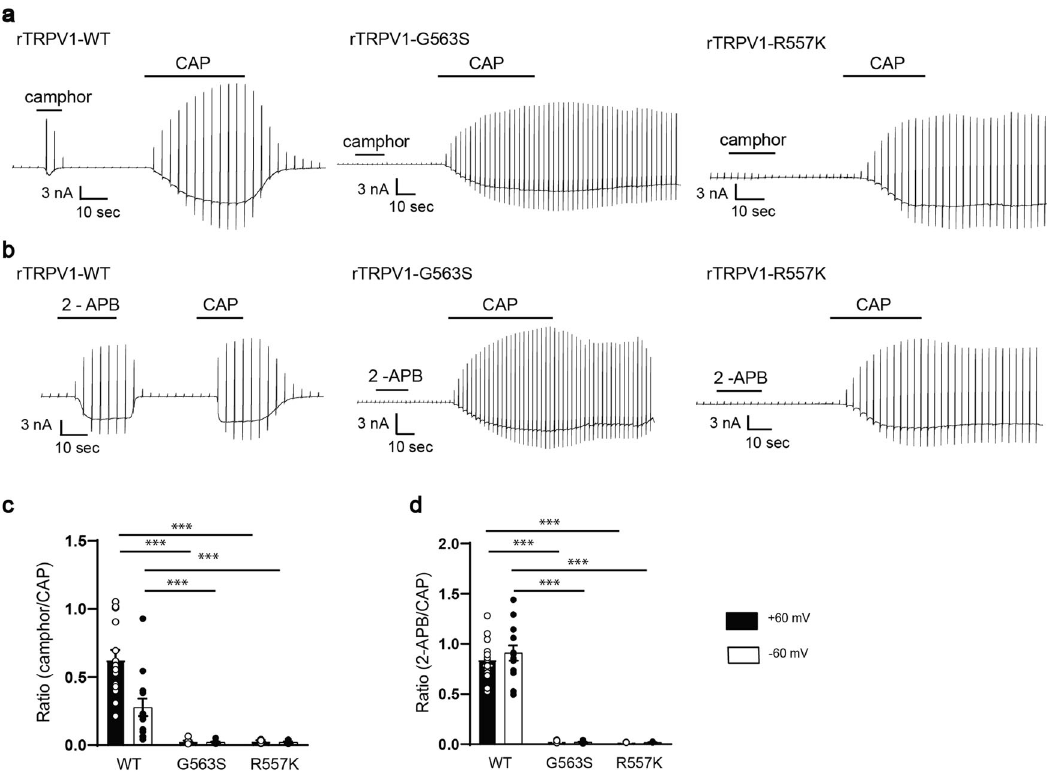
Fig. 4 Effect of rat TRPV1 mutations G563S and R557K on agonistic action of camphor and 2-APB. a Representative current traces for HEK293T cells expressing WT, rTRPV1-G563S, or rTRPV1-R557K stimulated with camphor (10 mM) followed by CAP (1 μ M). b Representative current traces for HEK293T cells expressing WT, rTRPV1-G563S, or rTRPV1-R557K stimulated with 2-APB (300 μ M) followed by CAP (1 μ M). c Comparison of the normalized current densities ( I camphor / I CAP ) for WT, rTRPV1-G563S, or rTRPV1-R557K expressed in HEK293T cells at ±60 mV ( I camphor / I CAP for WT: 0.63 ± 0.07 at + 60 mV and 0.28± 0.06 at − 60 mV, n = 14; G563S: 0.03 ± 0.01 at + 60 mV and 0.02 ± 0.01 at − 60 mV, n = 8; R557K: 0.03 ± 0.01 at + 60 mV and 0.02 ± 0.01 at − 60 mV, n = 5). d Comparison of normalized current densities ( I I 2-APB / CAP ) in HEK293T cells expressing WT, rTRPV1-G563S, or rTRPV1-R557K at ±60 mV ( I 2-APB / I CAP for WT: 0.84 ± 0.06 at + 60 mV and 0.91 ± 0.08 at − 60 mV, n = 13; G563S: 0.03 ± 0.004 at + 60 mV and 0.02 ± 0.004 at − 60 mV, n = 8; R557K: 0.02 ± 0.001 at + 60 mV and 0.02 ± 0.002 at − 60mV, n = 5). Holding potentials were − 60 mV with ramp-pulses ( − 100 to + 100 mV, 300 ms) applied every 3 s. Data represent means ± SEM. Statistical analysis was performed using two-sample t -test, *** p <